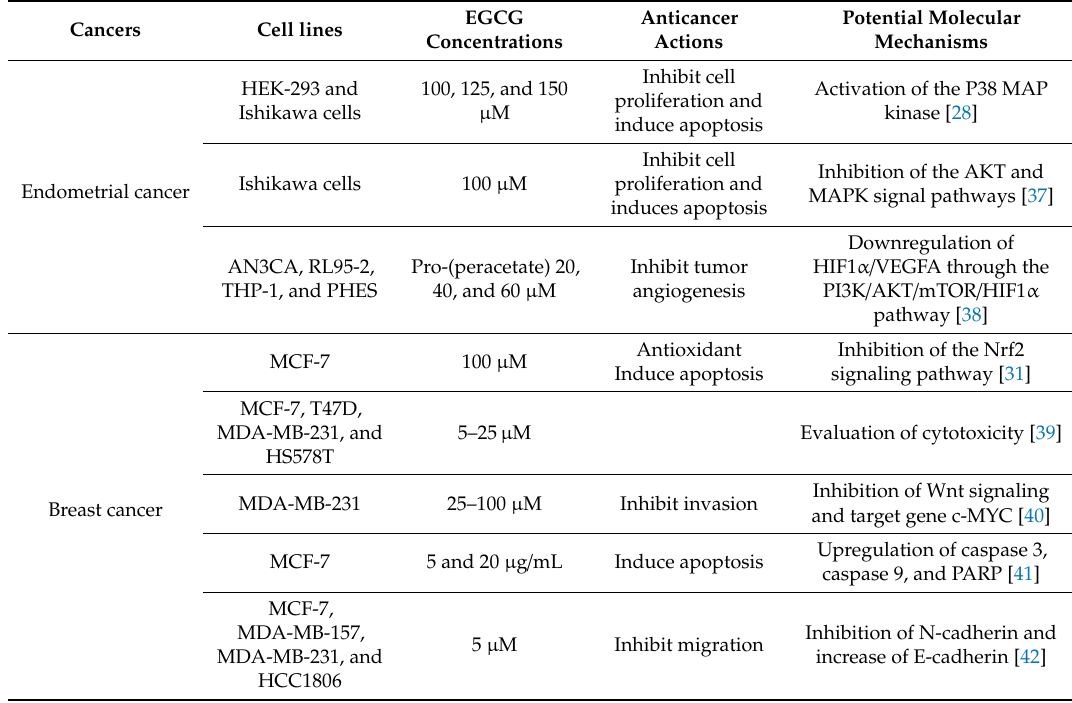
Table 1. Anticancer e ff ects of epigallocatechin gallate (EGCG) based on cell